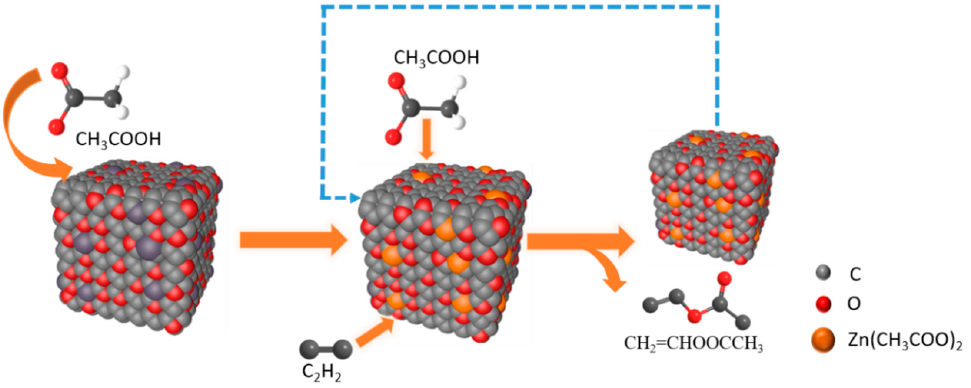
Figure 7. Reaction flow diagram taking Zn-O-C as an example.